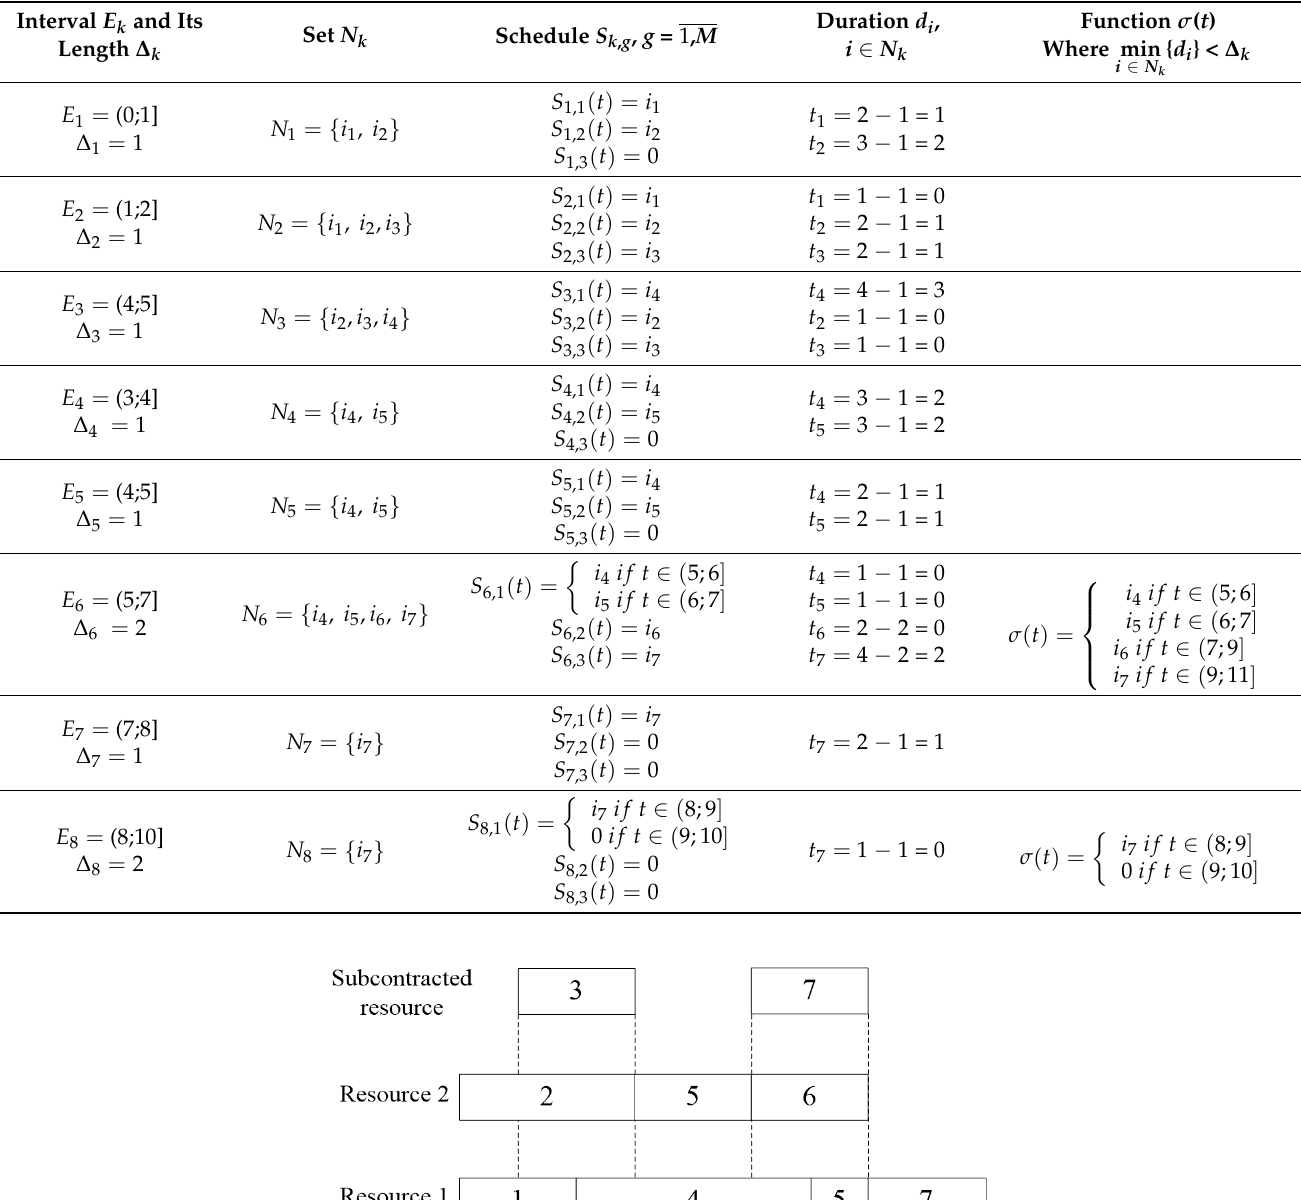
Table 5. Schedule search with orders’ due date by the V. S. Tanaev method.